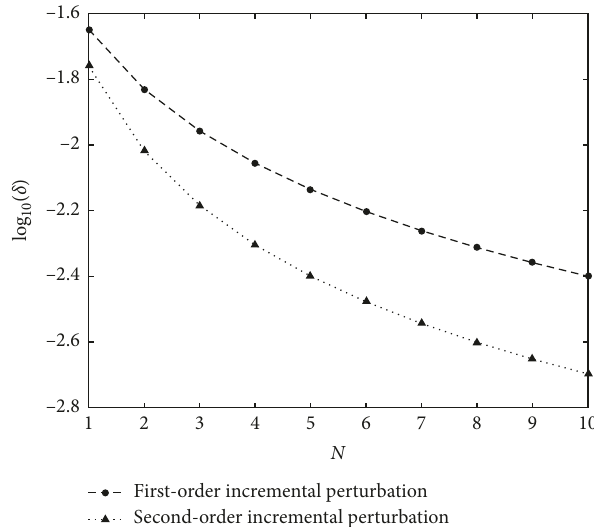
Figure 16: The error parameter, δ , for the perturbed modal ma- trices of the whirling beam as a function of N for σ � 0 . 5.